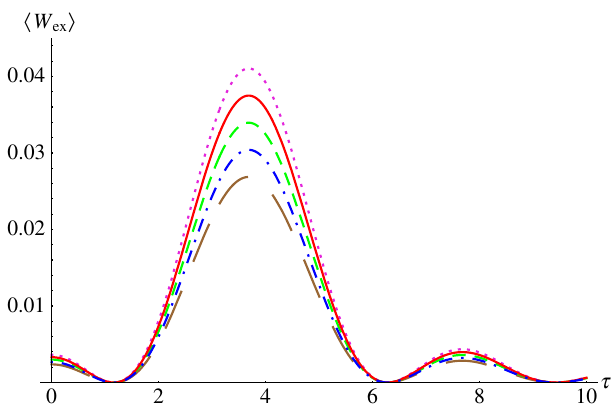
FIG. 15. Excess work under shortcut protocol driving as a function of the driving time for two statistical anyons with p B = 1 (long dashed, brown), p B = 0 (dotted, dark pink), p B = 1 / 2 (dashed, green), p B = 3 / 4 (dot dashed, blue), and p B = 1 / 4 (solid, red) using the shortcut protocol. Parameters are ω 0 = β = (cid:2) = 1, α = 1, κ = 2 and δω =